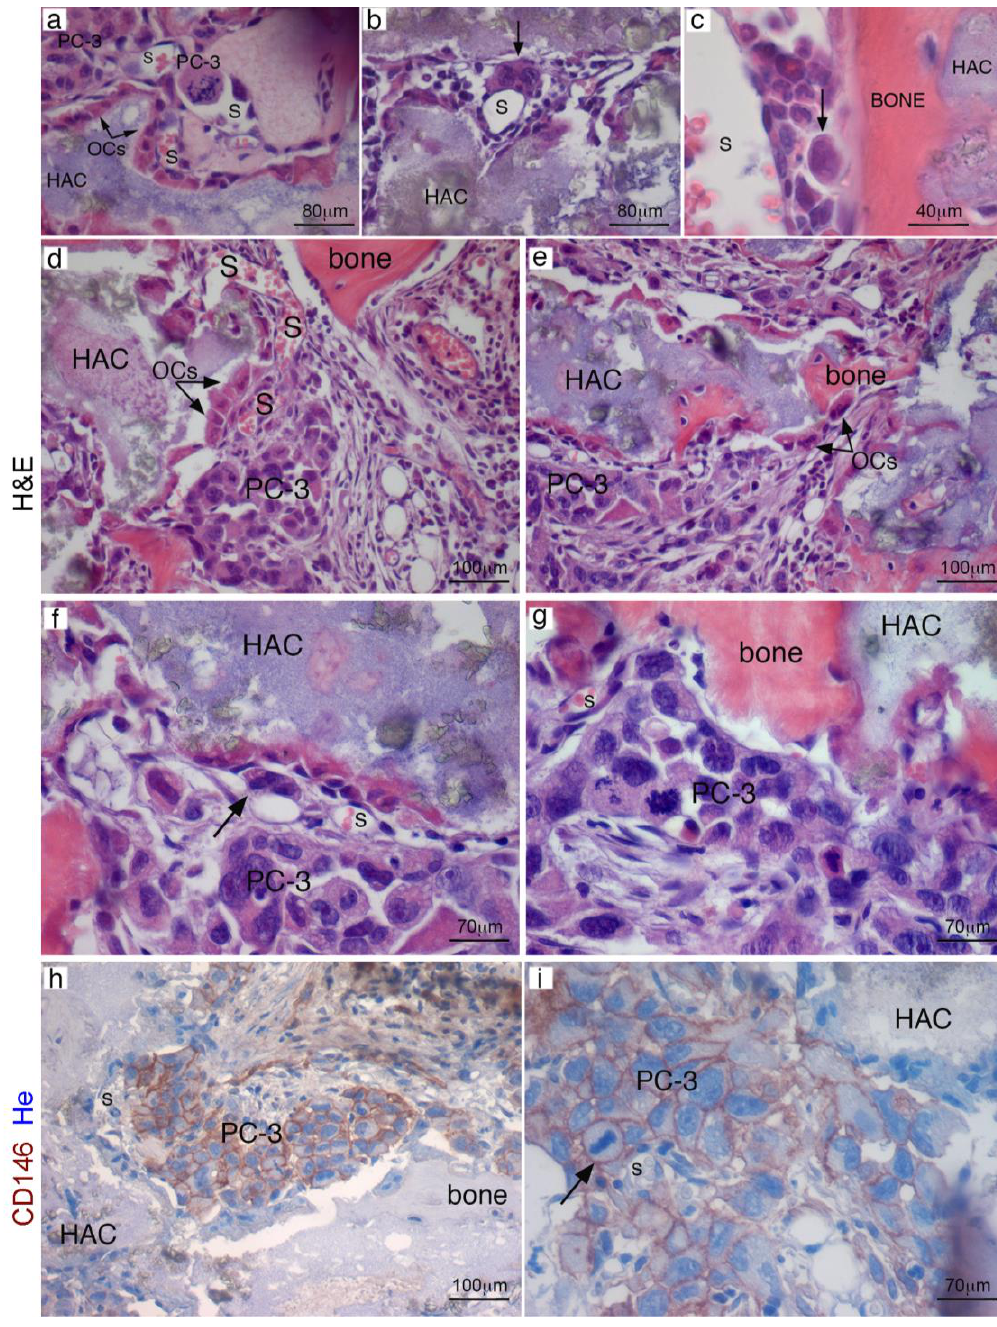
Figure 6. PC3 cells localization in extraskeletal bone/marrow ossicles and foci of cancer cells occupied a perisinusoidal position. In heterotopic transplants, single cancer cells can be observed inside sinusoids ( a ), wrapped around the outer surface of sinusoids ( b ) or near sinusoids, in the space between the vessel and bone ( c ). Early metastatic deposits were regularly associated with sinusoids and with the surfaces of bone or carrier particles ( d , e ). Intra-cardiac injected PC3 cells generated massive metastases in transplants ( f , g ). PC-3 metastases were identified by immunolabelling for human CD146 in ectopic marrow ossicles ( h , i ). HA/TCP particles (HAC), hematopoietic cells (hem); H&E, Hematoxylin/Eosin; OCs, osteoclasts; S, sinusoid. Scale bar = 40, 70, 80, 100 μm.